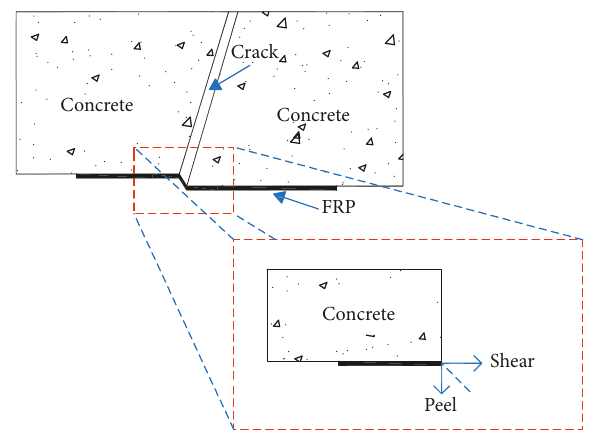
Figure 1: Peeling and shear stress in actual debonding